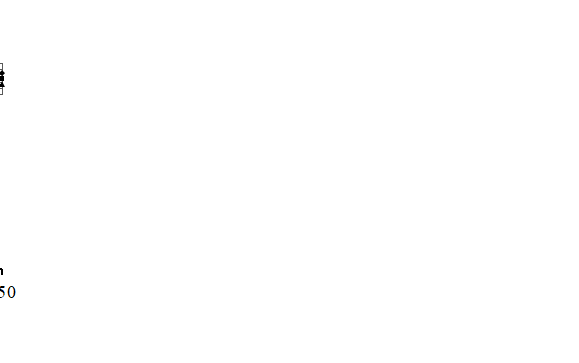
Table 1. Model discrimination results for the logistic-exponential kinetic model in fried potato chips. Group